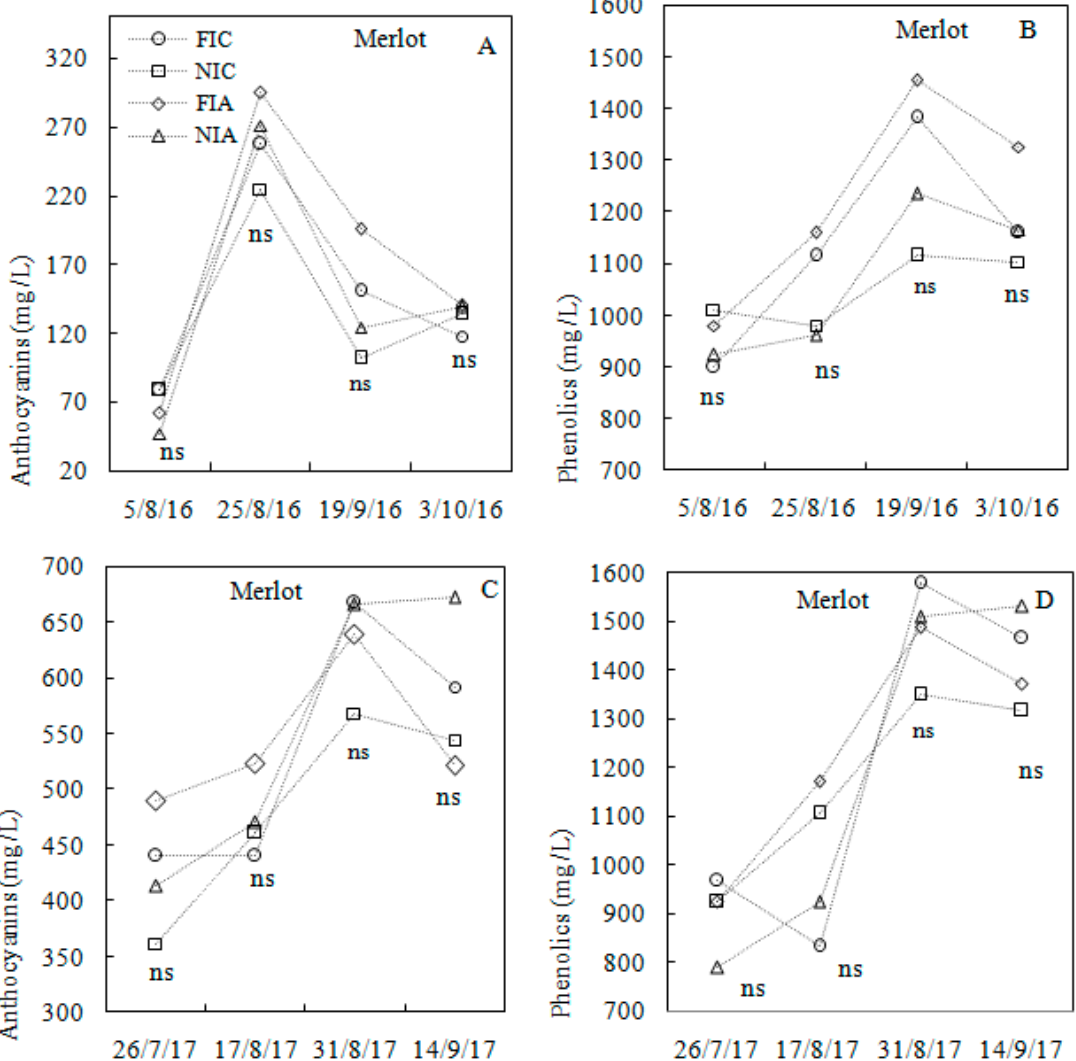
Figure 3. Seasonal variations of grape total Anthocyanins in 2016 (A) and 2017 (C) and Phenolics in 2016 (B) and 2017 (D) in cv. ‘Merlot’. FIA= full irrigation (+) ABA; FIC= full irrigation ( − ) ABA; NIA= no irrigation (+) ABA NIC = no irrigation ( − ) ABA. ns indicates no significant differences at P ≤